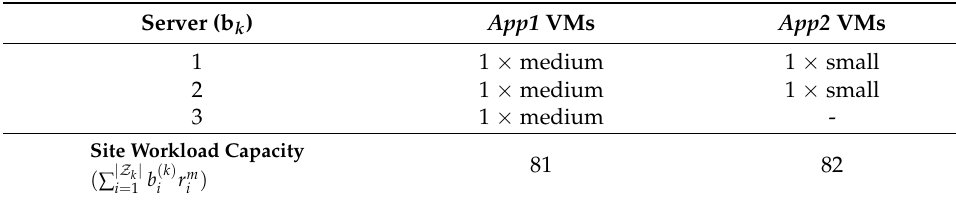
Table 2. VM formations selected by the MRF